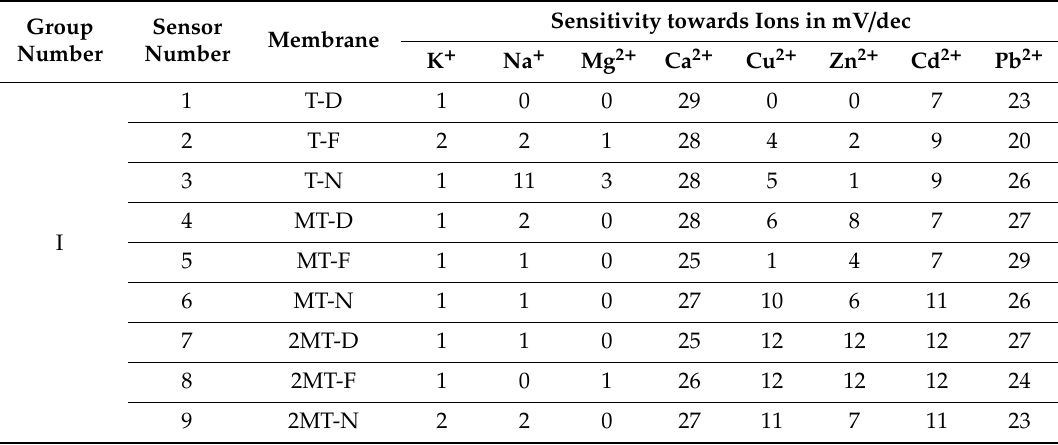
Table 2. Sensitivity values of the sensors in the solutions of single- and double-charged cations. Standard deviations of the slope values were in the range of 1–3 mV /